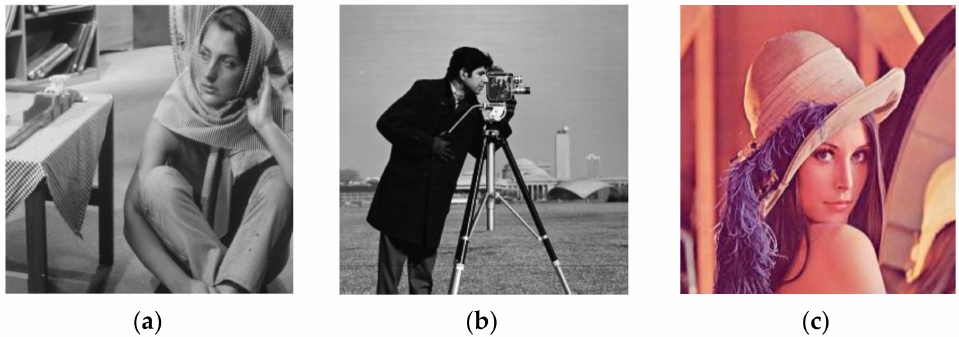
Figure 1. Test images. ( a ) Barbara, ( b ) Cameraman and ( c ) Lena. The simulations used two types of noise: additive white Gaussian noise (AWGN) measured by its standard deviation σ and its mean m and the salt and pepper